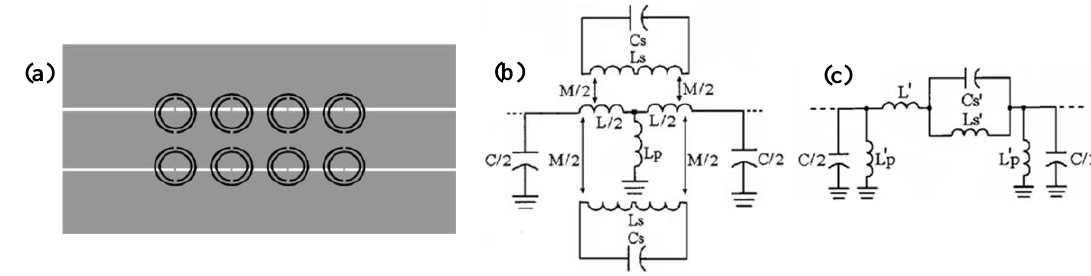
Figure 9. ( a ) Typical topology of a SRR- and strip-loaded CPW. ( b ) Equivalent circuit model of the unit cell. ( c ) Transformed circuit